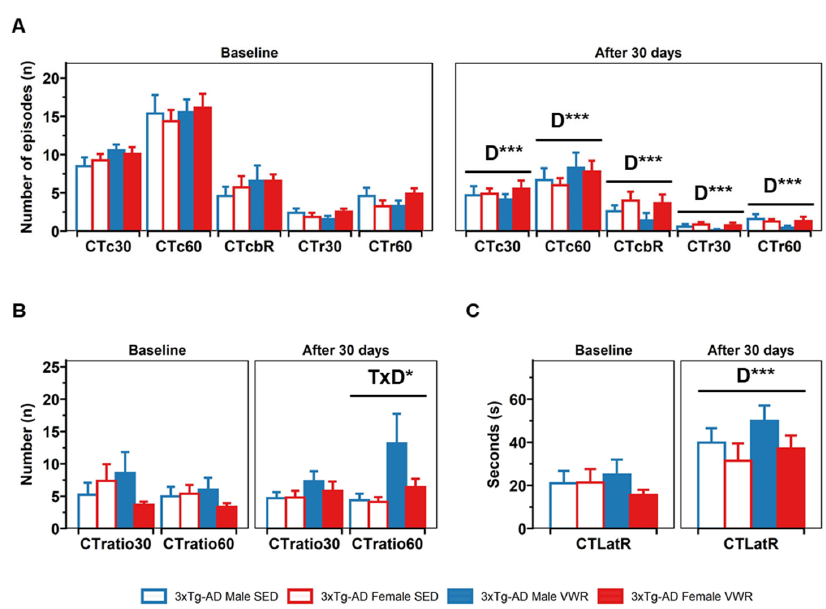
Figure 2. Corner test. ( A ) Horizontal activity: number of corners visited at 30 s (CTc30) and 60 s (CTc60), number of corners before rearing (CTcbR), rearing at 30 s (CTr30) and 60 s (CTr60) ( B ) ratios of horizontal/vertical activity: corners visited/n rearings at 30 s (CTratio30) and 60 s (CTratio60) and ( C ) vertical activity: rearing latency (CTLatR). Factorial analysis: D, days; T, treatment; S, sex. * p < 0.05; *** p <